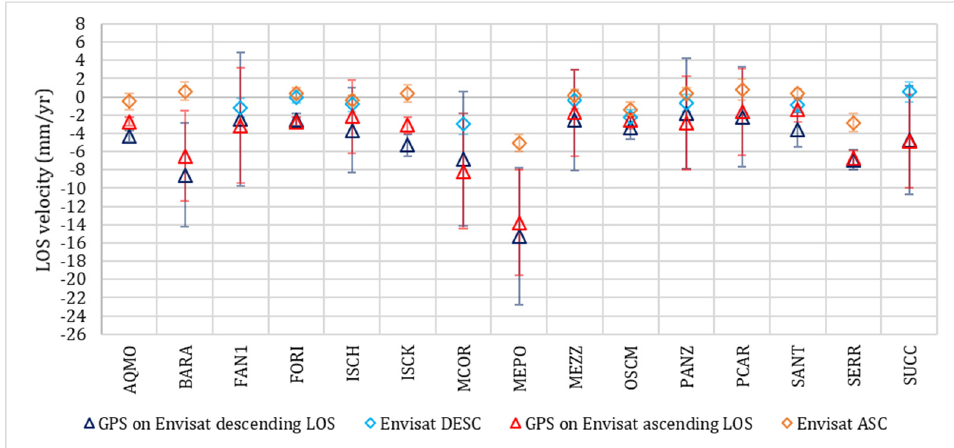
Figure 4. Comparison between GPS displacement rates reprojected on Envisat descending (blue triangles) and ascending (red triangles) LOS and, respectively, displacement rates evaluated through SBAS processing: descending track (light blue diamonds) and ascending track (orange diamonds).